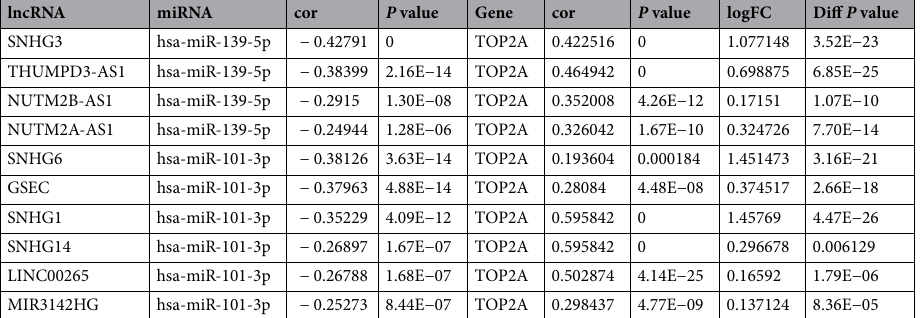
Table 3. The relationship between lncRNAs and miRNAs, lncRNAs and TOP2A, and the lncRNAs expression in LIHC and control tissues.